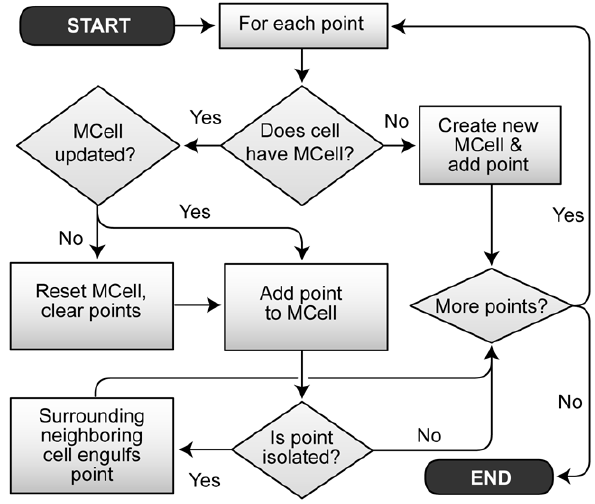
Figure 11. MCell point assignment flow chart. An MCell point has no specific cystogenesis counterpart. Once per simulation cycle, each point is assigned to the MCell agent associated with the CELL enclosing that point. MCell point lists are initialized during each simulation cycle. Additionally, surrounding CELLS engulf isolated points.